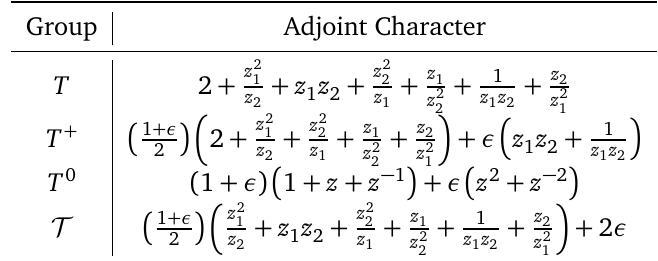
Table 7: Character for the adjoint representation of (cid:221) SU ( 3 ) for various fugacity sub-